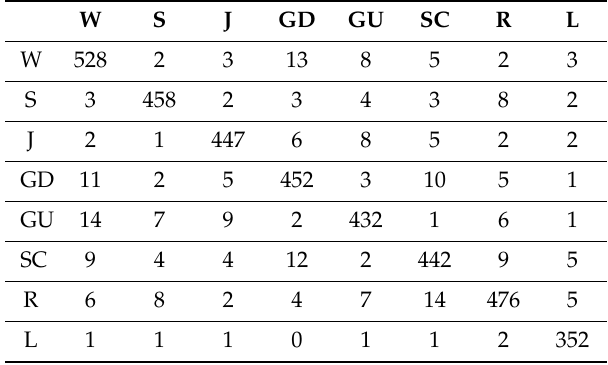
Table 5. Confusion matrix for HAR using 20 base classifiers based on Fisher discriminant analysis (FDA) features.